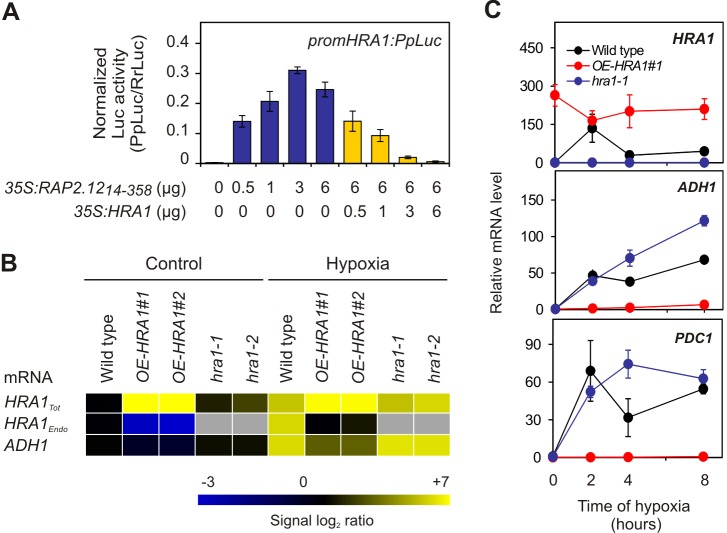
A negative feedback loop acting on HRA1 determines the extent of anaerobic gene expression over the time of stress.(A) Modulation of HRA1 promoter activity, as visualized through the firefly luciferase reporter, by co-transfection of protoplasts with a stabilized RAP2.1214–358, alone (blue bars) or in combination with a HRA1 effector construct (yellow bars). Data are mean ± s.d. (n = 4). (B) Steady-state levels, in Arabidopsis seedlings, of the full-length HRA1 mRNA (HRA1Endo), measured with specific HRA1 3′-UTR primers, and of full-length (in the wild type), truncated (in hra1-1 and -2), and overexpressed transcripts (in OE-HRA1-#1 and -#2) (HRA1Tot), measured with primers specific for HRA1 coding sequence; see Figure S4B for the position of primers used for HRA1Tot and HRA1Endo mRNA abundance measurement. Hypoxia, 2 h. Data are mean ± s.d. (n = 3 ). The absence of expression is indicated by grey rectangles (masked). Numeric expression values are provided in Table S5. (C) Abundance of HRA1 and hypoxia marker gene mRNAs over prolonged hypoxia stress in OE-HRA1 and hra1 seedlings. Data are mean ± s.d. (n = 4).